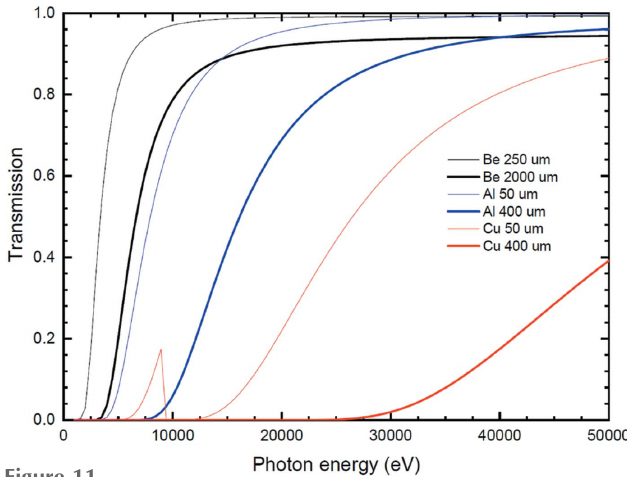
Figure 11 The different material and thickness absorption foils transmittance.